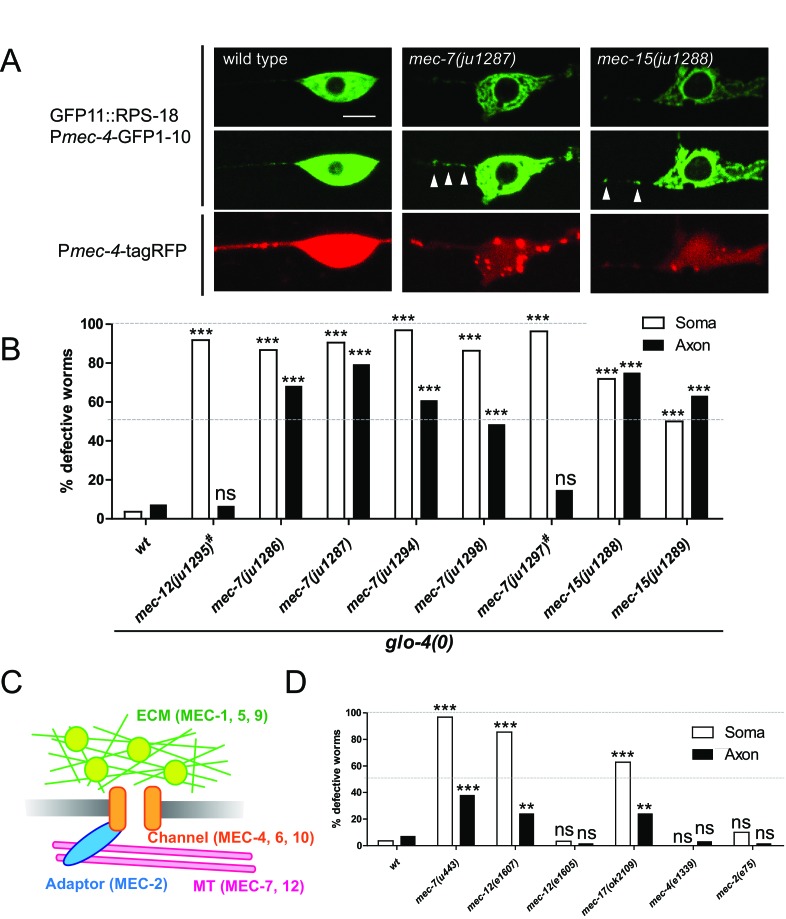
Ribosome distribution defects in tubulin mutants.(A) Ribosome distribution in the ALM soma and proximal axon using Pmec-4-RIBOS in the indicated backgrounds. Brightness was adjusted in the middle panels to show the puncta in the proximal axons in the mec-7 and mec-15 mutants (white arrowheads). TagRFP intensity was decreased in the mec-7 and mec-15 mutants (bottom panels), consistent with a previous report (Bounoutas et al., 2011). Scale bar: 5 µm. (B and D) The fraction of worms showing the ribosome distribution defects in the soma or in the axon of ALM neurons in the indicated genetic backgrounds. # indicates dominant mutants. 50–70 worms were analyzed. Statistics: Fisher’s exact test, compared to the wild type control, ns: p>0.05, **p<0.01, ***p<0.001. (C) Schematic of mechanotransduction components in C. elegans. Representative proteins of each component are shown in brackets. ECM: extracellular matrix; MT: microtubules.